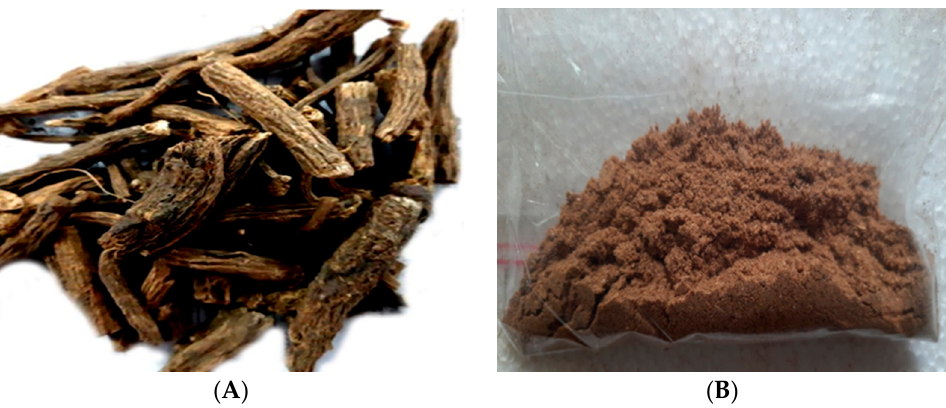
Figure 1. Images of ( A ) Saussurea lappa root and ( B ) coarse